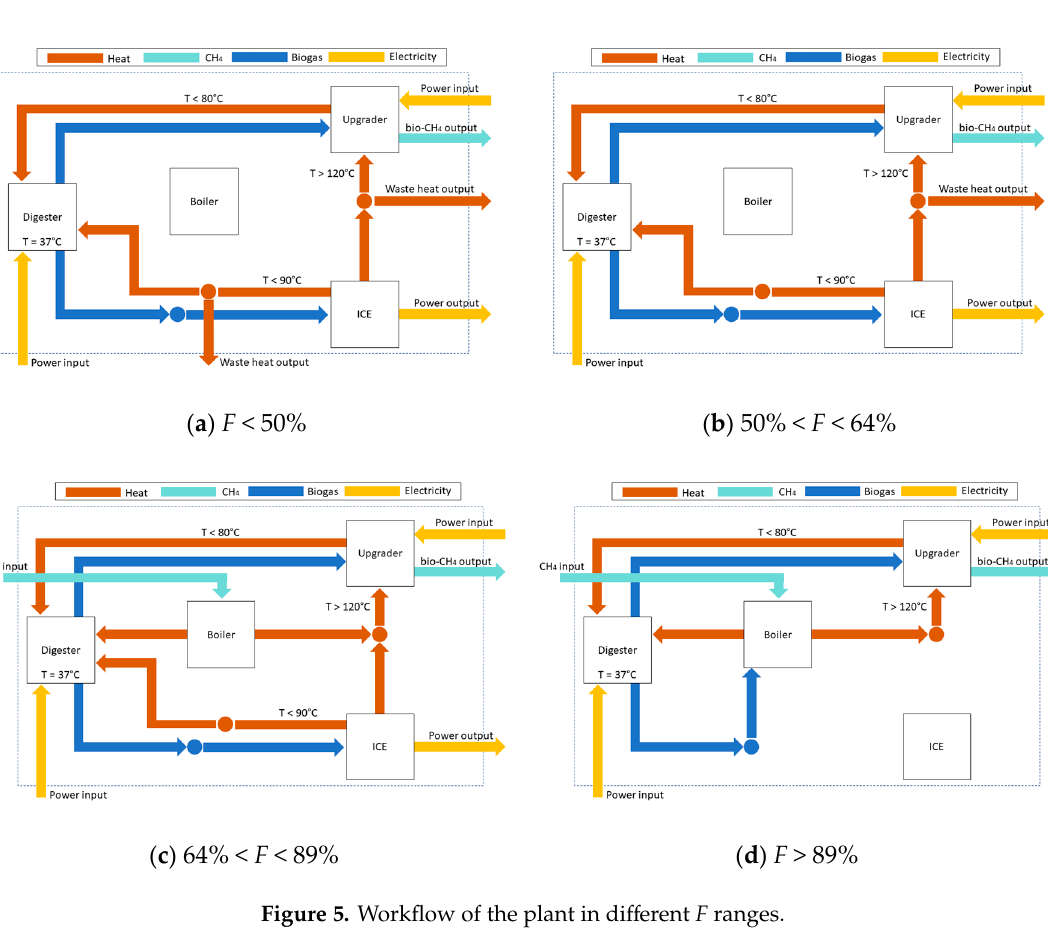
Figure 5. Workflow of the plant in different F ranges.